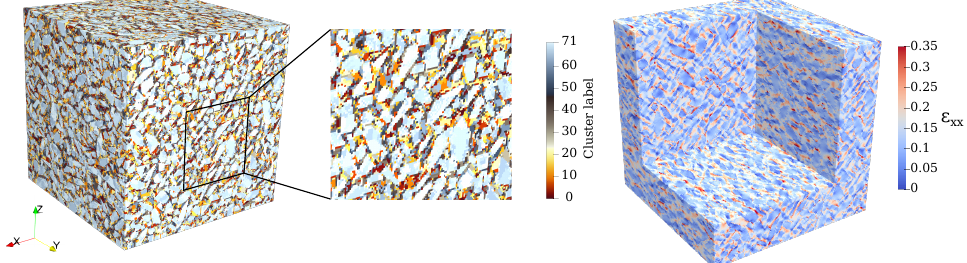
Figure 13. Left and center: Visualisation of the clustered mesostructure of the virtual concrete specimen obtained from the k-means cluster algorithm, Right: One of the strain components ( ε xx ) that was used to compute the clusters shown in the image on the left, the red color indicates high values of positive strain components, which correlates with